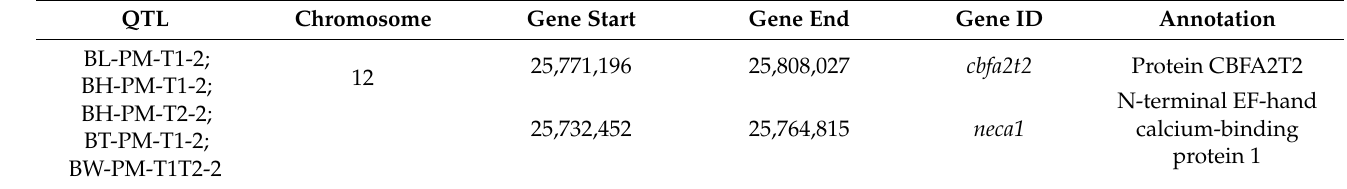
Table 8. Candidate genes associated with maternal effects in Yellow River